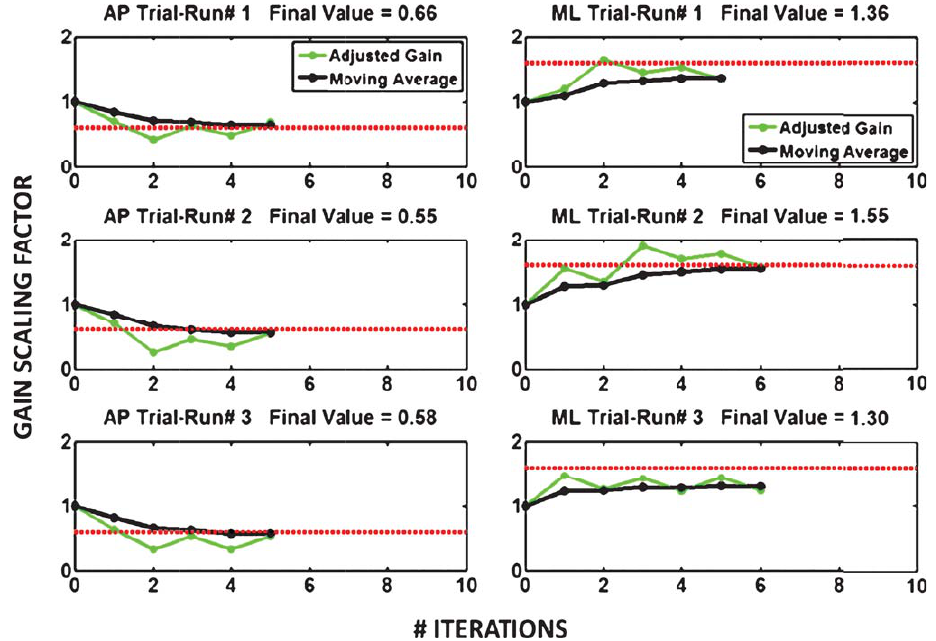
Fig. 4. Results for three trial-runs applying test algorithm to adapt gain scaling factor towards presumed optimal values (denoted by dotted line) in anterior-posterior (AP) and medial-lateral (ML) dimensions. Each trial-run was completed in less than 5 min- utes. The average total number of shifts the subject performed across all trial runs was 41.5 ± 4.9.